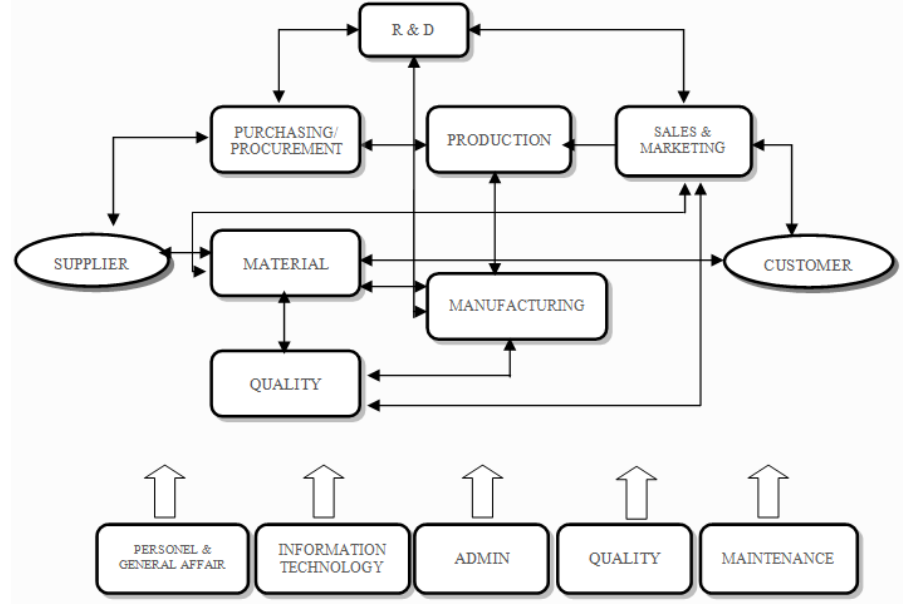
Fig. 2. Functional value chain of a